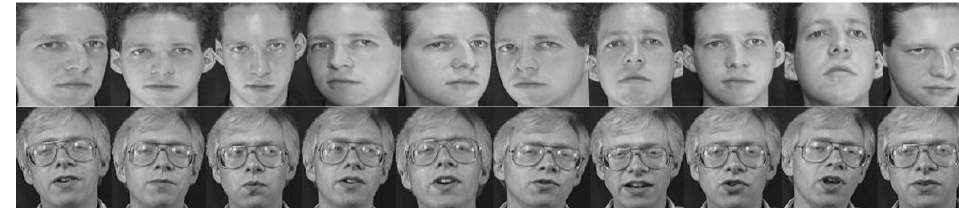
Figure 2. Samples from the ORL dataset.